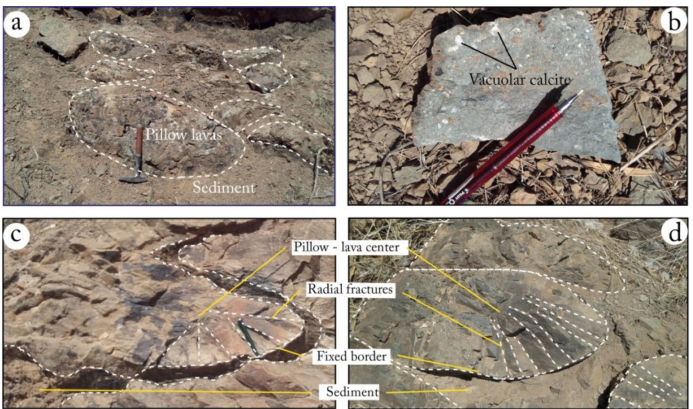
Figure 6. ( a ) Pillow-lavas, ( b ) vacuolar basalt, ( c ) detailed pillow structure showing radial fractures and ( d ) pillow-lava in contact with greenish pelites.